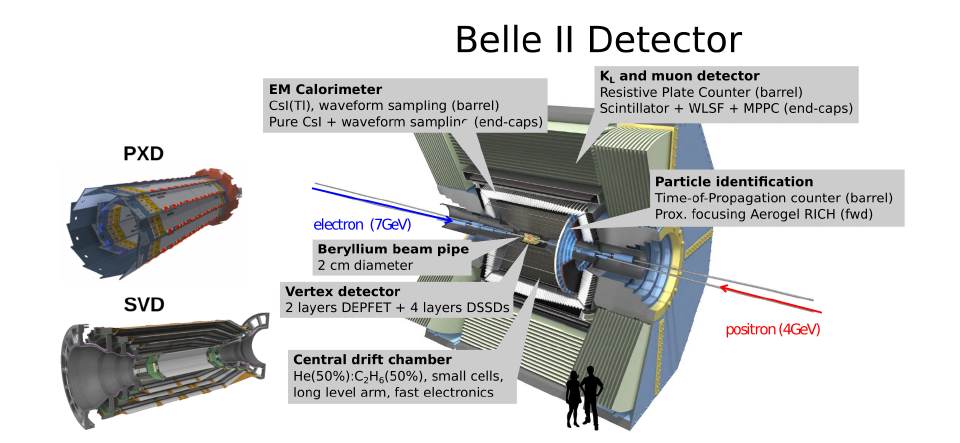
Figure 1: Cross-section of the Belle II detector with its sub-detector systems. Pixel (PXD) and strip (SVD) detectors are shown separately. Main new and / or upgraded features of each sub-detector are highlighted in the captions.